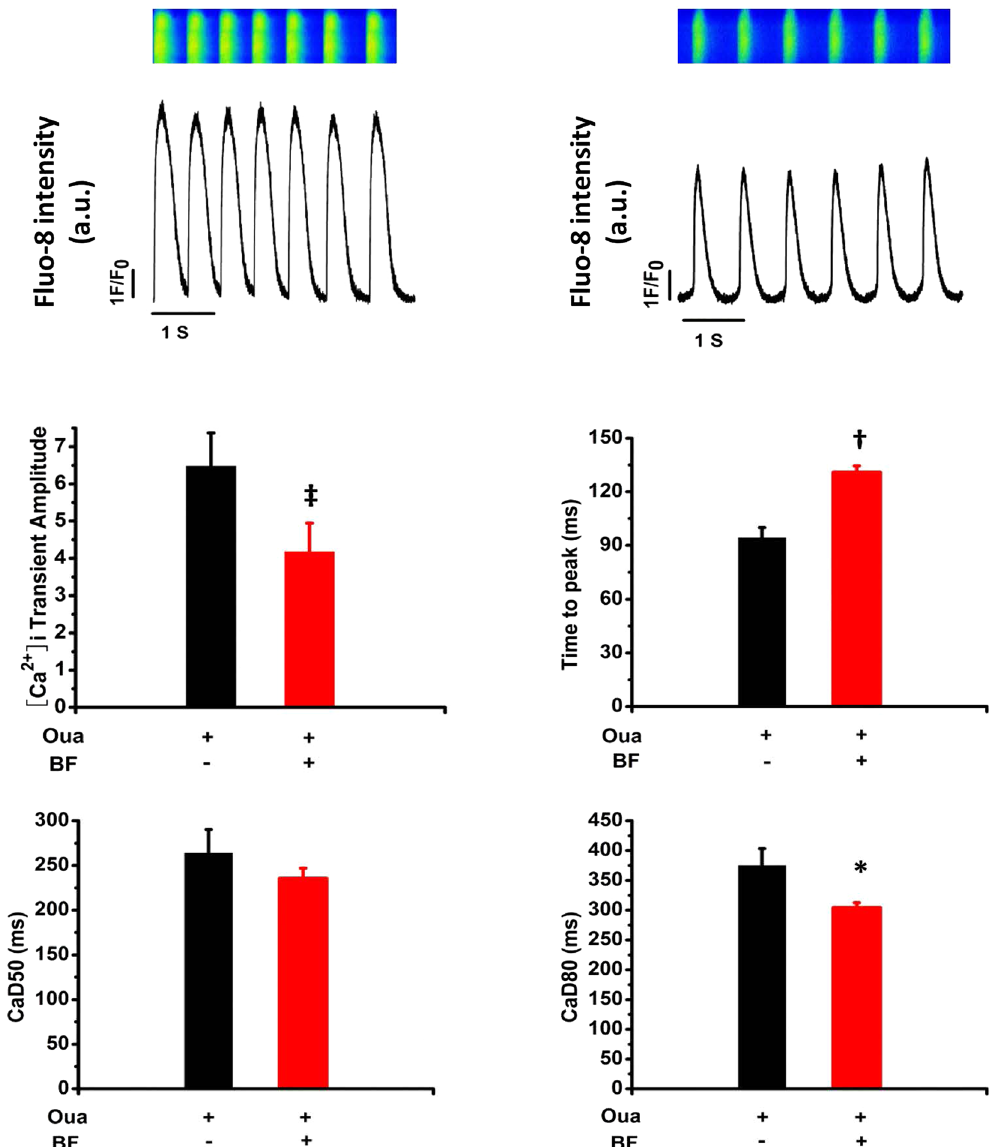
Figure 4. Effect of BF on [Ca 2 + ] i transients in hESC-CMs. Spontaneous [Ca 2 + ] i transients were recorded in Fluo-8 loaded hESC-CMs pre-treated with 10 µ M Oua for 5 minutes followed by 10 µ M BF. ( A ) Representative traces of [Ca 2 + ] i transients recorded in a cell at baseline (with Oua) and with subsequent exposure to BF. The relative [Ca 2 + ] i transients intensity is plotted as fluorescence ratio (F 1 /F 0 ). ( B ) Bar-graphs show [Ca 2 + ] i transient amplitude, time to peak and duration (CaD) at 50% and 80% recovery (CaD50 and CaD80, respectively). * p < 0.05, † p < 0.01, ‡ p < 0.001, vs. baseline. n =